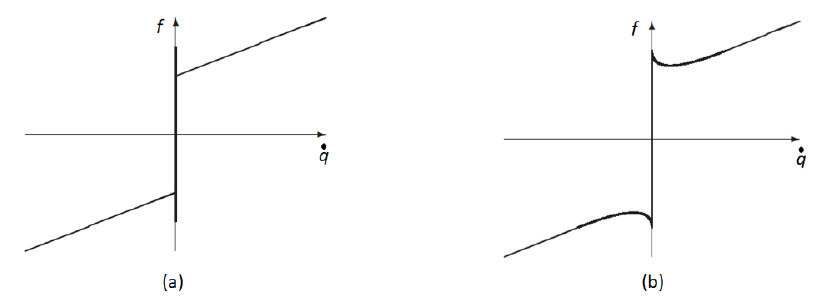
Figure 4. ( a ) Static-viscous-Coulomb friction and ( b ) Stribeck friction models.